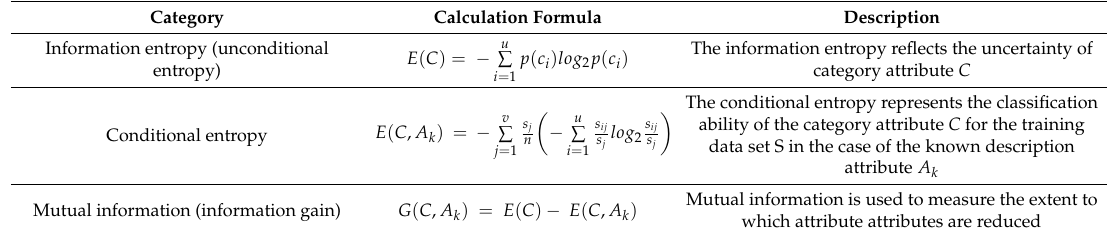
Table 7. Mutual information of description attribute calculation method.